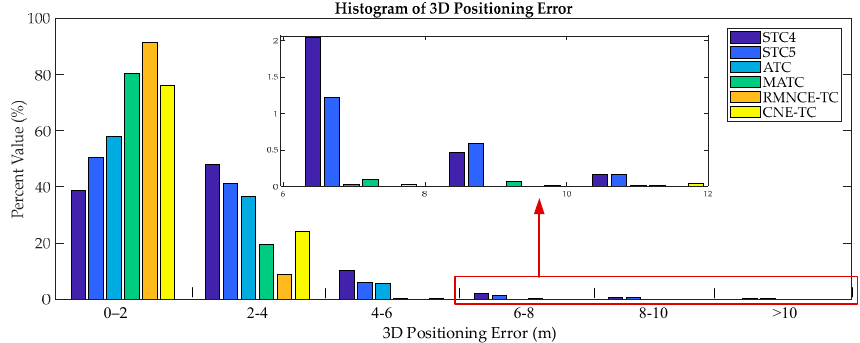
Figure 15. Histogram of the positioning errors obtained for the test schemes.